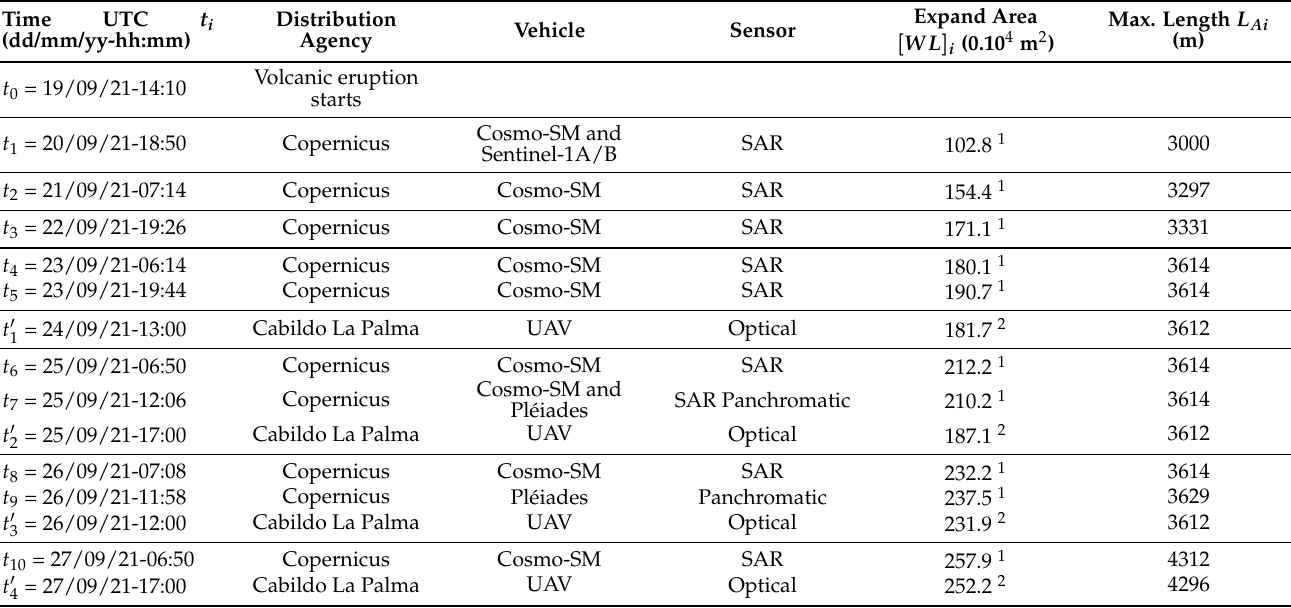
Table 1. Catalogue of the temporal evolution of lava flow perimeters used in this study.